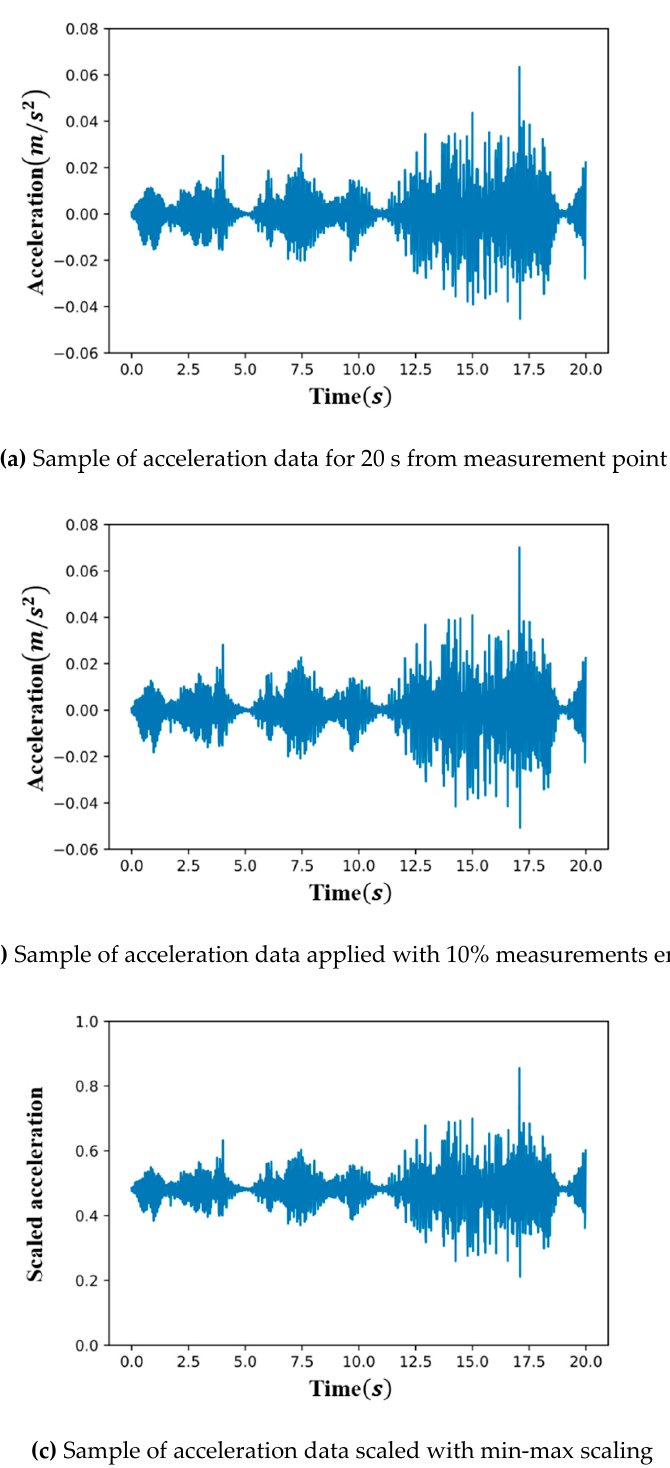
Figure 7. Example of the process for applying the measurements error and min ‐ max scaling.